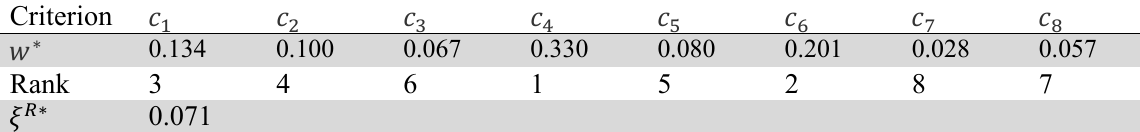
Weight and ranking of each criterion in the nominal problem of example 4.( e=0 in uncertain problem) Criterion